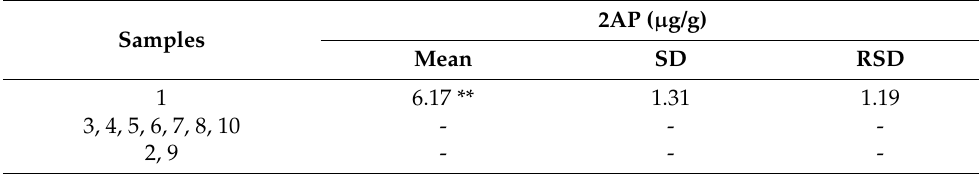
Table 3. 2AP content of 10 F 2